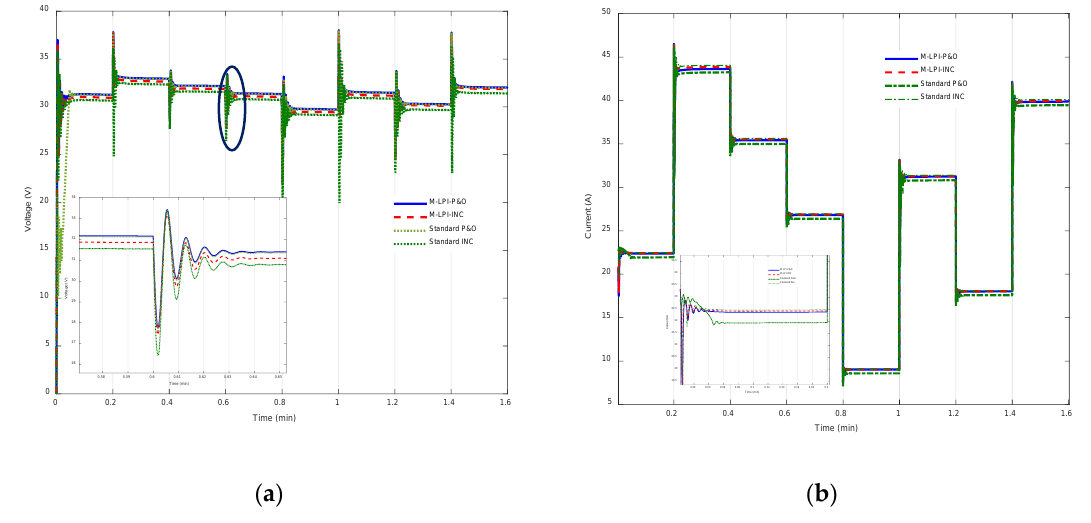
Figure 12. Photovoltaic ( a ) voltage and ( b ) current.